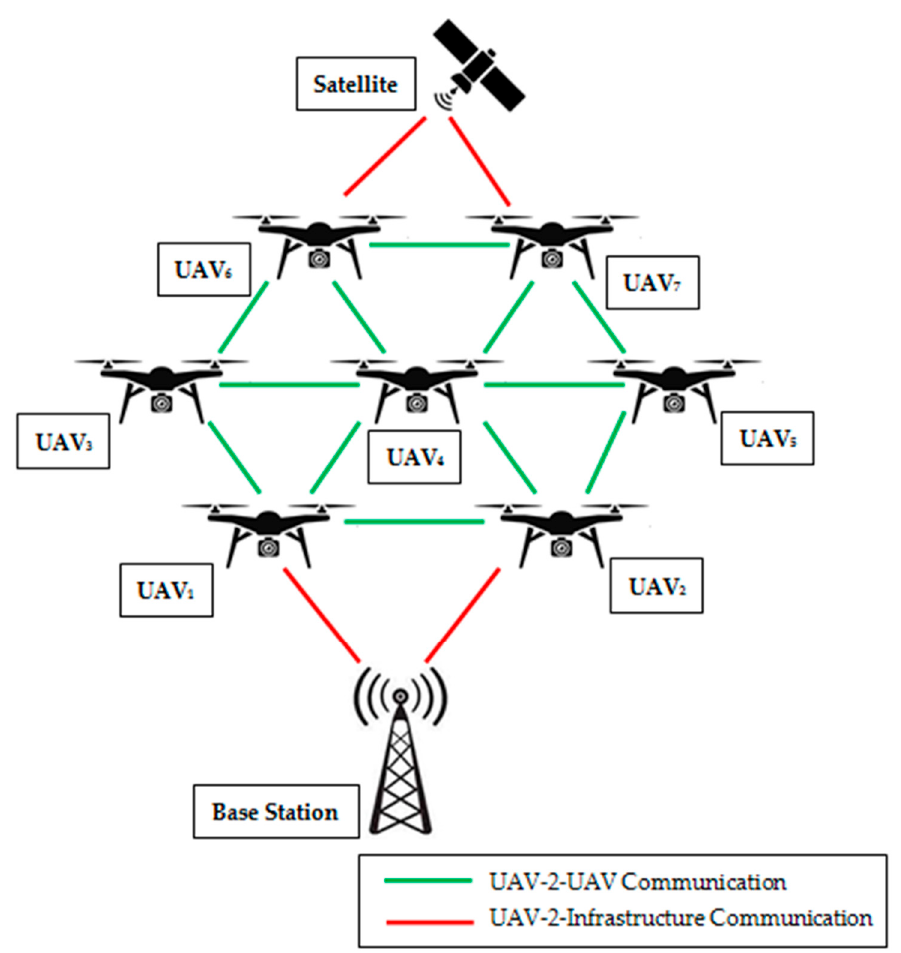
Figure 1. The architecture of flying ad-hoc networks.